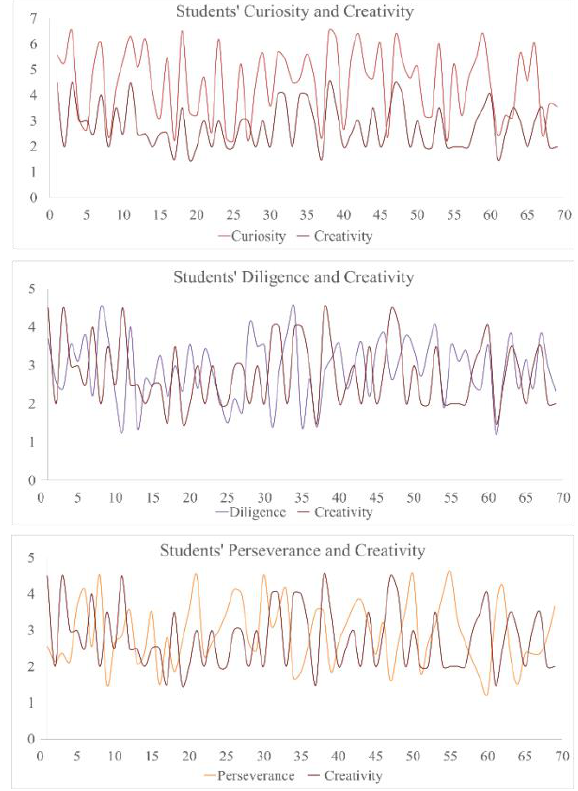
Fig. 5: Creativity mapping with curiosity, diligence and